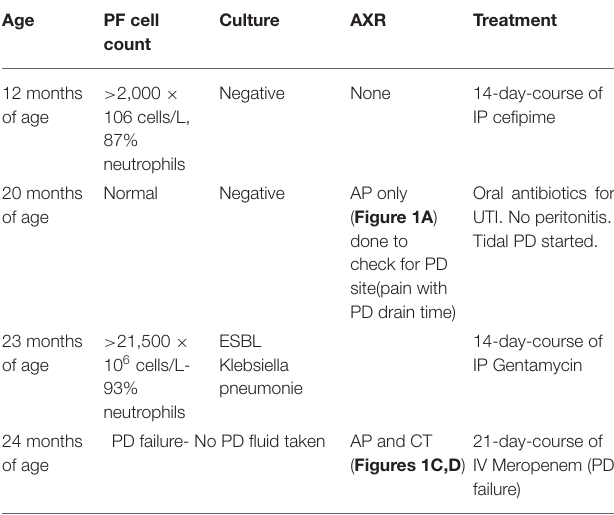
TABLE 1 | PD related complications in our patient. TABLE 2 | Terminology related to